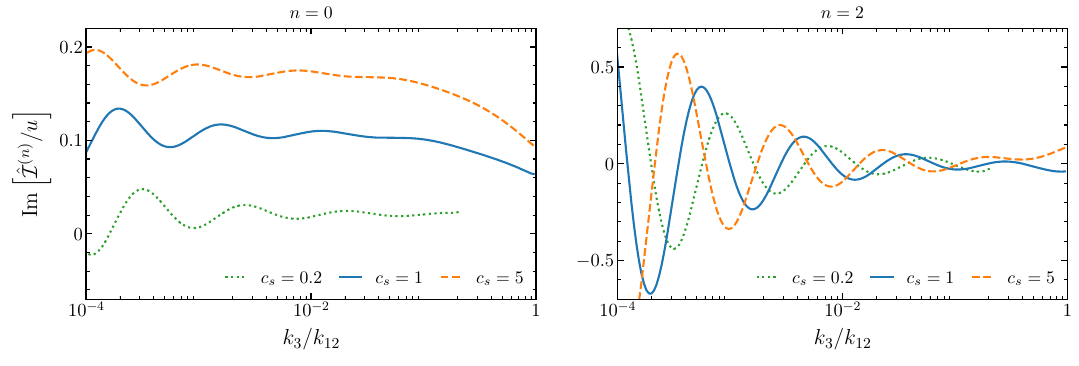
Figure 4 . Analytical solutions of the generalized scalar seeds for n = 0 ( left ) and n = 2 ( right ), with µ = 3 and the sound speed ratio c = 0 . 2 , 1 , 5 . Since we work on the solutions for u ∈ [0 , 1] , s the plots are stopped at k when c 1 3 /k 12 < c s s <